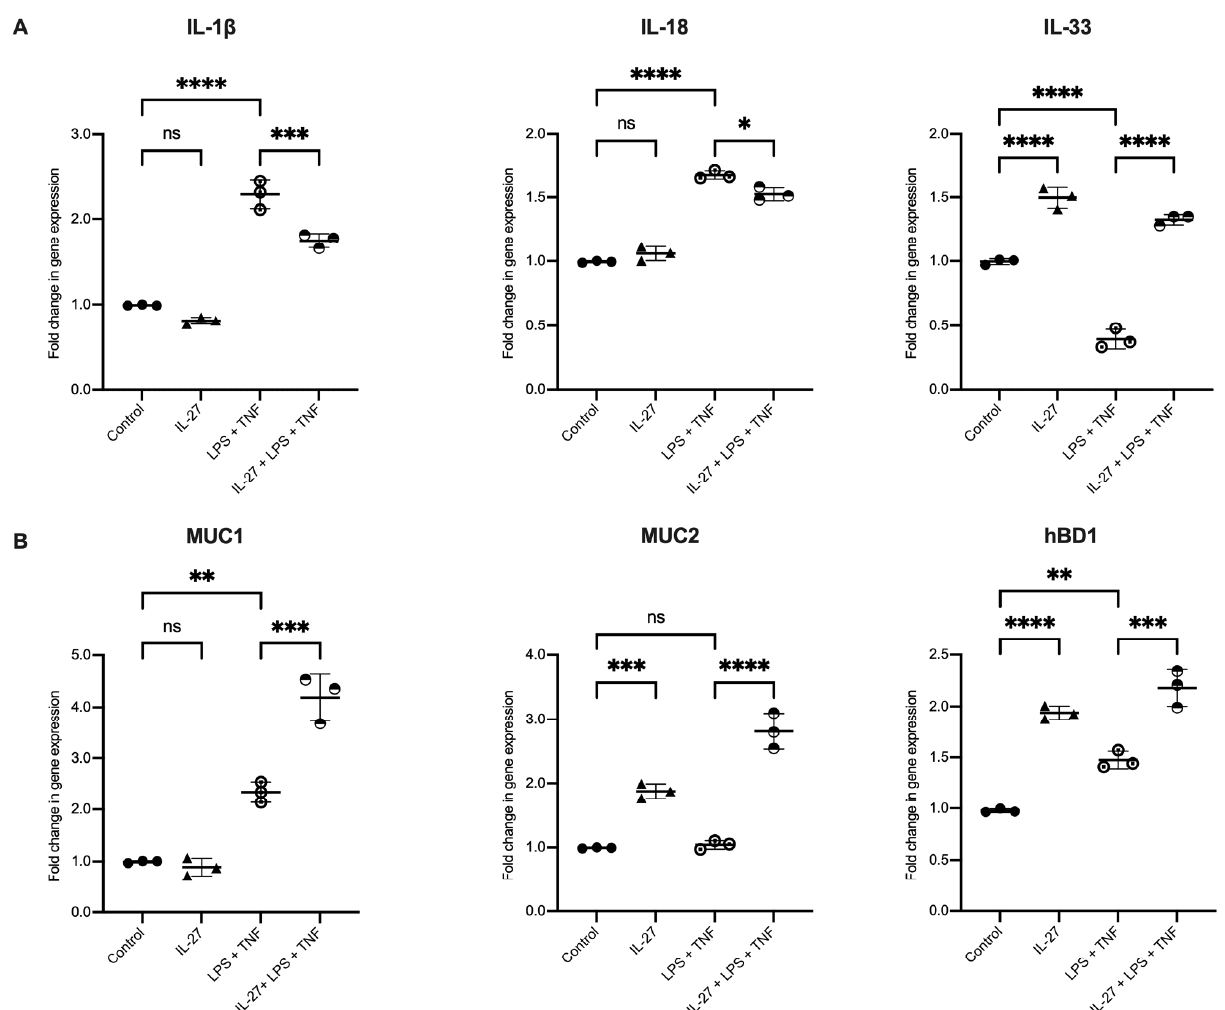
Figure 4. IL-27 stimulated human gastrointestinal epithelial barrier-derived innate immunity. Human colonic organoids stimulated with rhIL-27 (100 ng/mL), LPS (500 ng/mL), TNF- α (100 ng/mL) and combinations of the three as indicated. ( A ) Gene expression of epithelial-derived cytokines compared to unstimulated controls. ( B ) Expression of mucins (muc) − 1 and − 2 and human beta defensin 1 (hBD1). Gene expression normalised to GAPDH; n = 3 individual patient-derived organoids, with 3 technical replicates/experiment, presented as mean ± SD. Statistical analysis with one-way ANOVA with Bonferroni correction. * p < 0.05, ** p < 0.01, *** p < 0.001 and **** p < 0.0001; ns = not